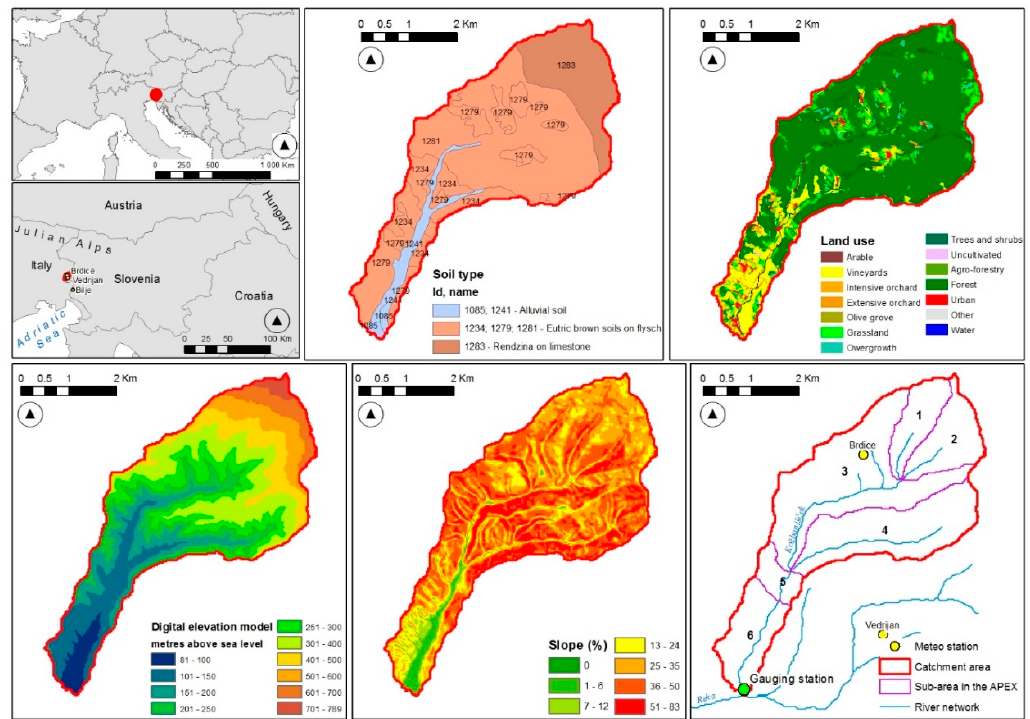
Figure 1. The study area of the Kožbanjšˇcek stream catchment in Goriška Brda, Slovenia: elevation, slope, soil type, land use, stream network, representing the Agricultural Policy/Environmental eXtender (APEX) model sub-areas.